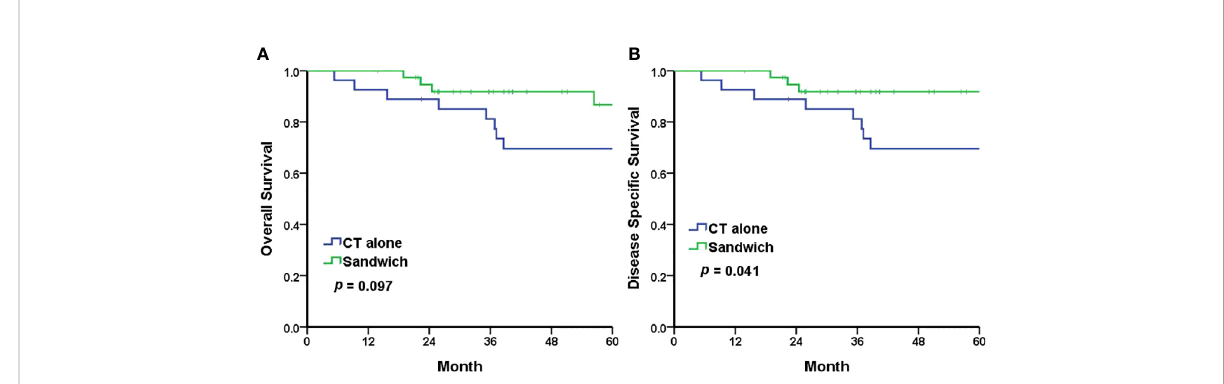
FIGURE 2 The Kaplan – Meier survival curves for 5-year overall survival (A) and 5-year disease-speci fi c survival (B) . CT